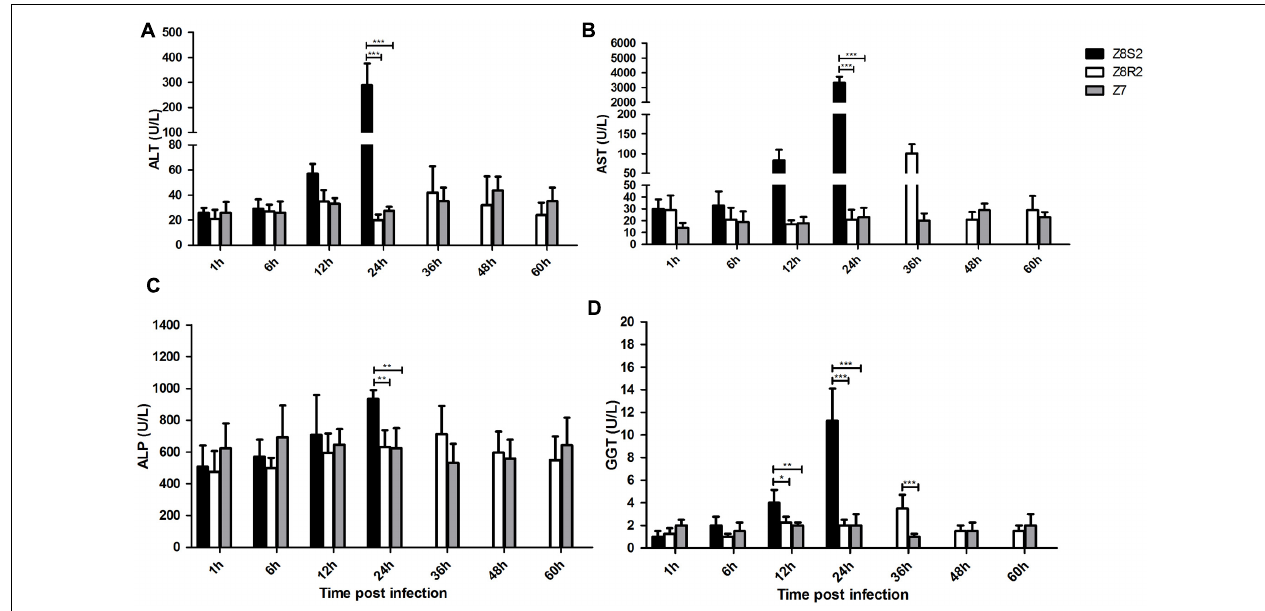
FIGURE 3 | Detection of serum biochemical markers ALT (A) , AST (B) , ALP (C) and GGT (D) . For group Z8S2, sera were sampled from live ducklings between 1 and 12 h and from ducklings showing clinical signs at 22 h. For groups Z8R2 and Z7, sera were sampled from live ducklings between 1 and 60 h. Groups Z8S2, Z8R2 and Z7 were compared with each other for statistical significant differences using two-way ANOVA followed by Student’s t -test. ∗ P < 0.05; ∗∗ P < 0.01; ∗∗∗ P < 0.001.